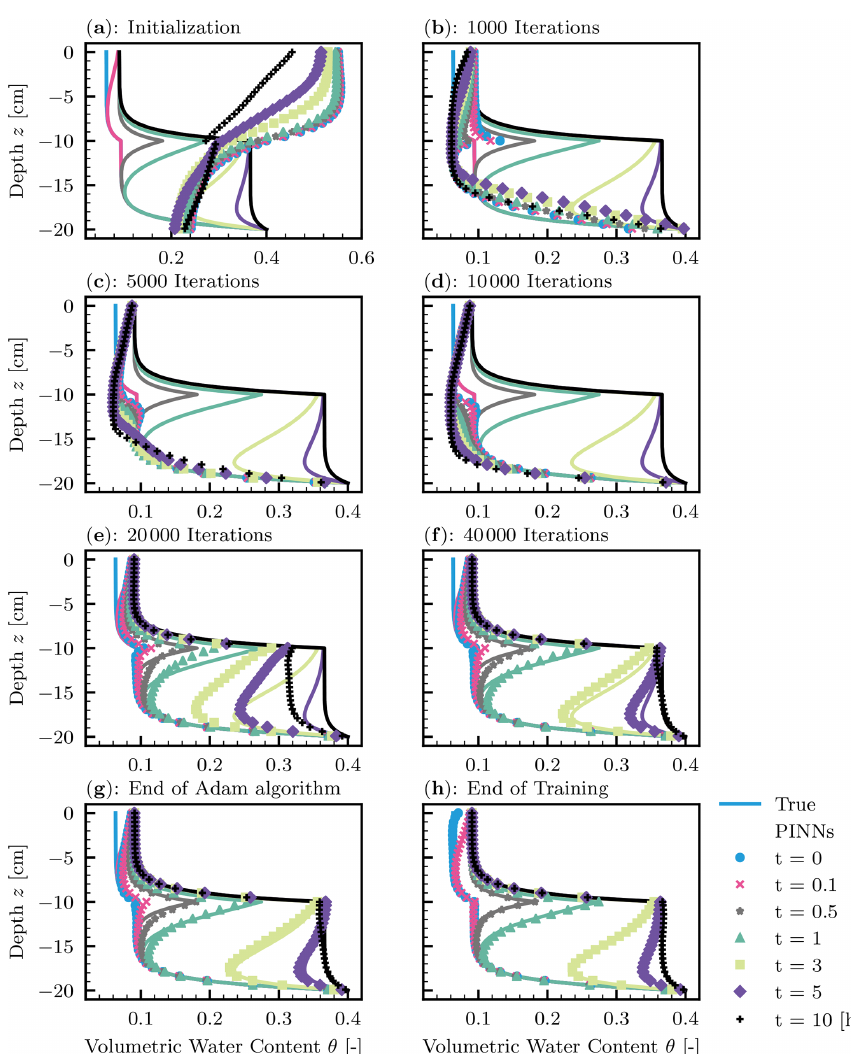
Figure 13. Heterogeneous soil. The evolution of the PINN solution during the training. (a) Initialization of the PINNs. (b–f) 1000, 5000, 10000, 20000, and 40000 iterations of the Adam algorithm. (g) The end of 100000 iterations of the Adam algorithm. (h) The end of the L-BFGS-B